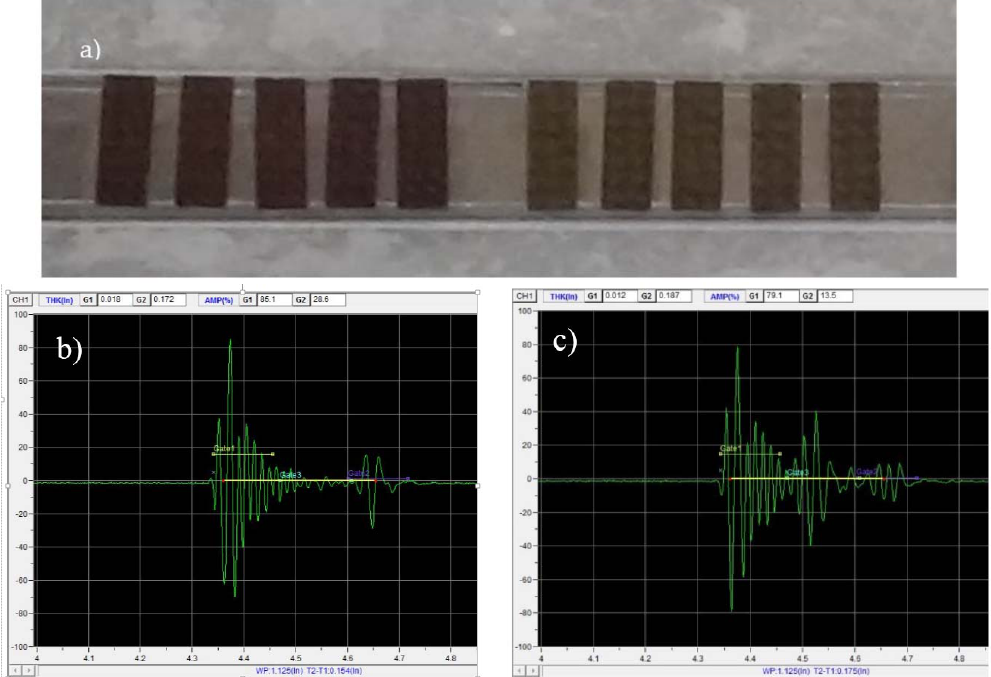
Figure 3. ( a ) Image of short ‐ beam samples aligned in immersion tank for ultrasonic testing; ( b ) ‘A ‐ scan’ data from undamaged area of a sample. ( c ) ‘A ‐ scan’ data from damaged area of a sample.